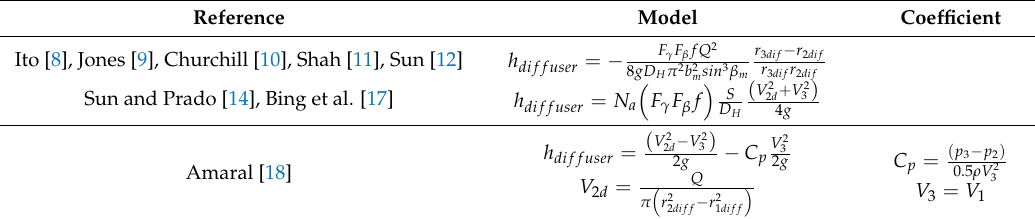
Table 5. Diffuser loss models in